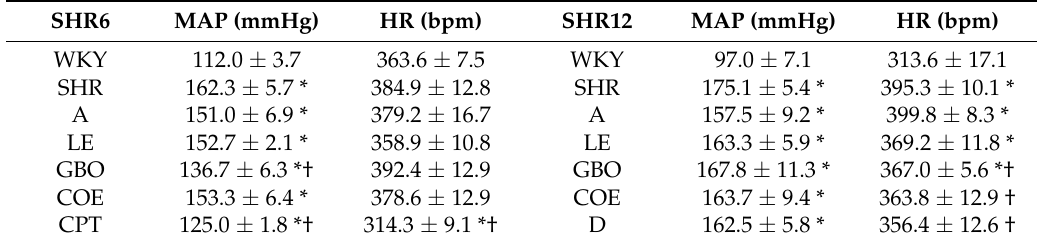
Table 2. Final mean arterial pressure (MAP) and heart rate (HR) in the experimental groups.